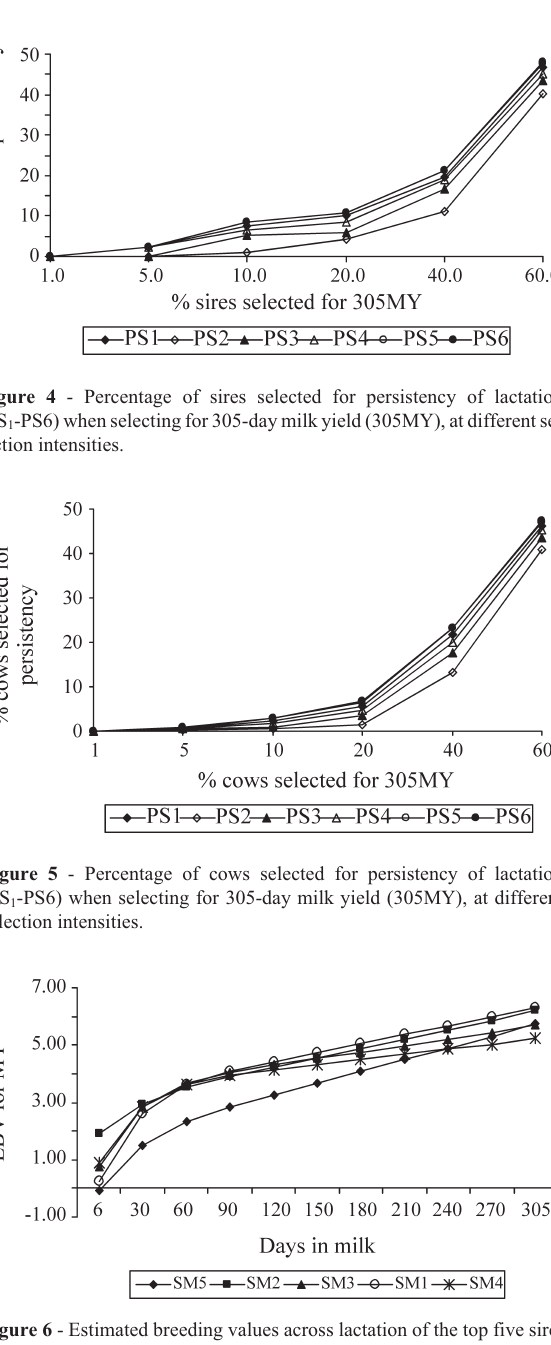
Figure 3 - Dispersal in ranking of sires with more than 25 daughters for 305-day milk yield (305MY) and persistency of lactation (PS 6 ).